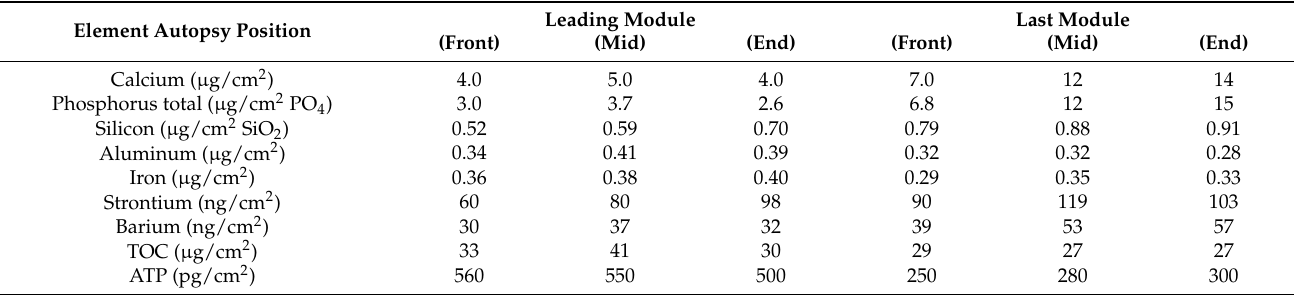
Table 6. Detection of fouling and scaling relevant parameters on autopsied membranes.